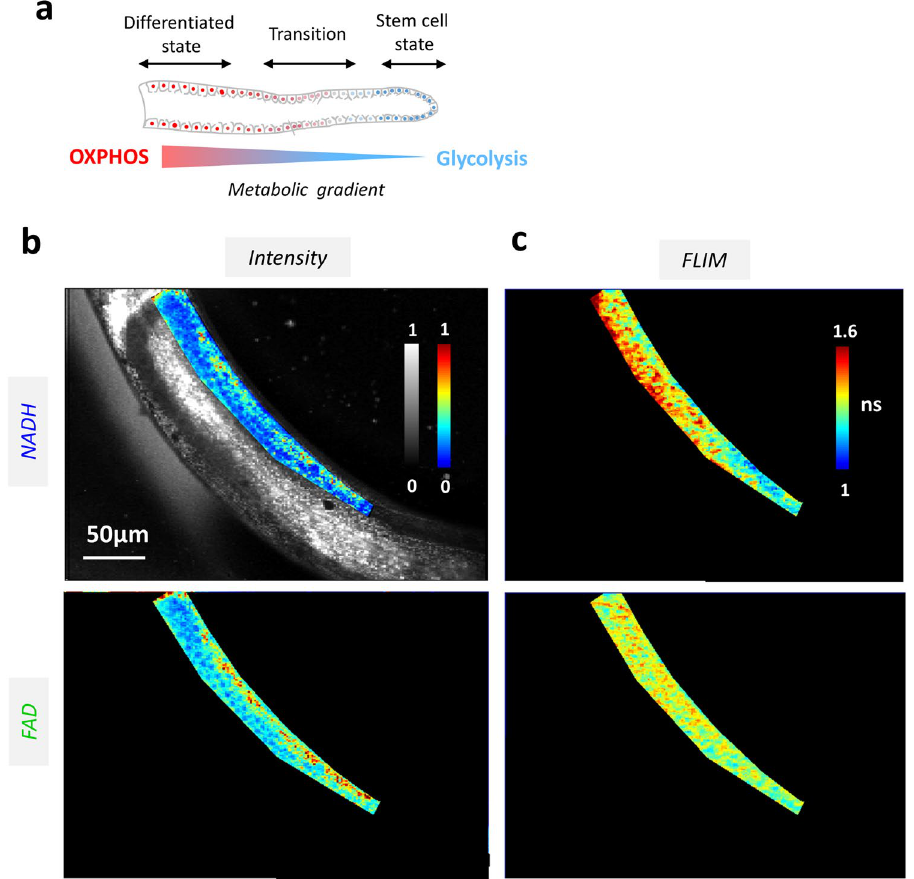
that are located at the tip of the germ line; a metabolic gradient along the axis of the germ line goes from an energetic metabolism dominated by glycolysis in proliferating stem cells to one dominated by OXPHOS in the differentiated cells 39 . ( b , c ) NADH and FAD intensities ( b ) and lifetimes ( c ) are simultaneously acquired. Time per pixel, 160 µ s. Triplicate experiments were